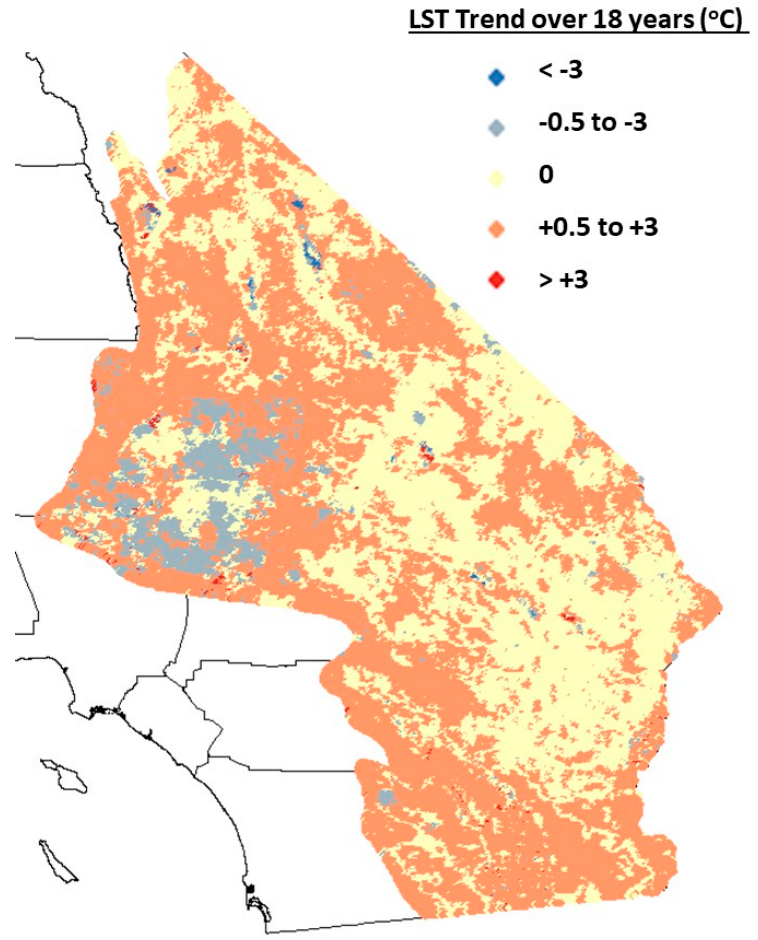
Figure 11. Map of slope trends detected from structural change analysis of LST between 2000 and 2018 for MODIS 1-km monthly time series. Positive (warming) LST slope values in orange-red shades and negative (cooling) LST slope values in blue shades; areas of no change in LST are shaded in yellow.